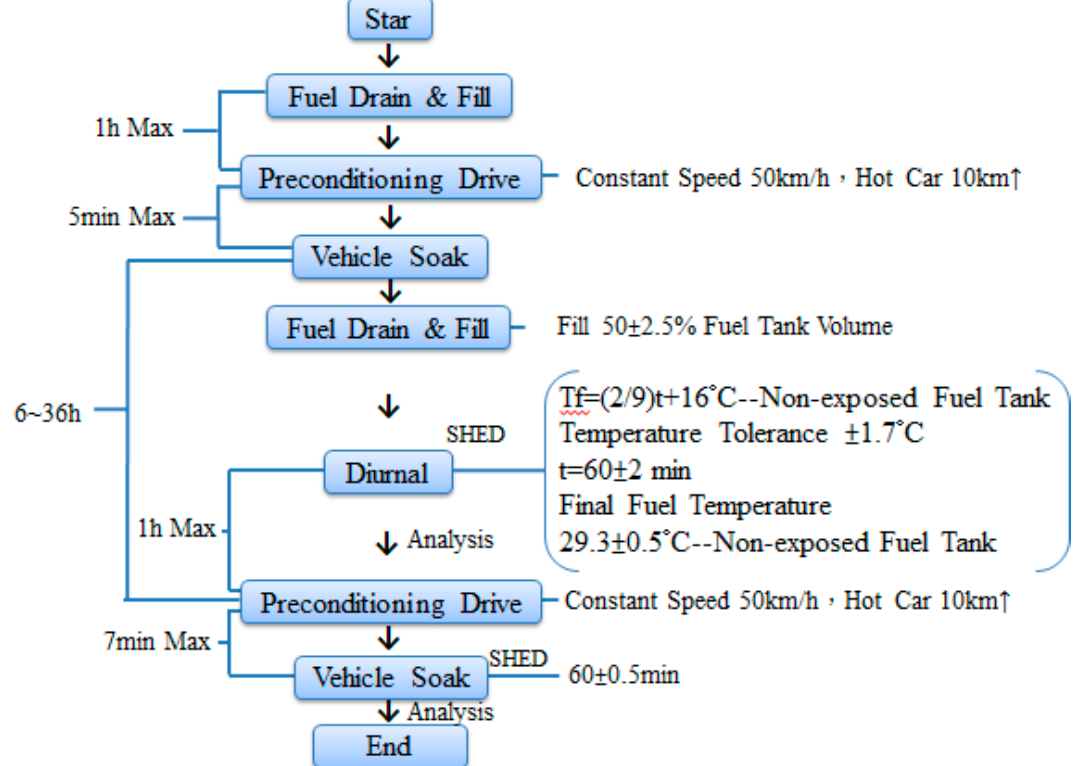
Figure 6. Process flow chart of SHED (Sealed Housing for Evaporative Determination) test in Taiwan [13].